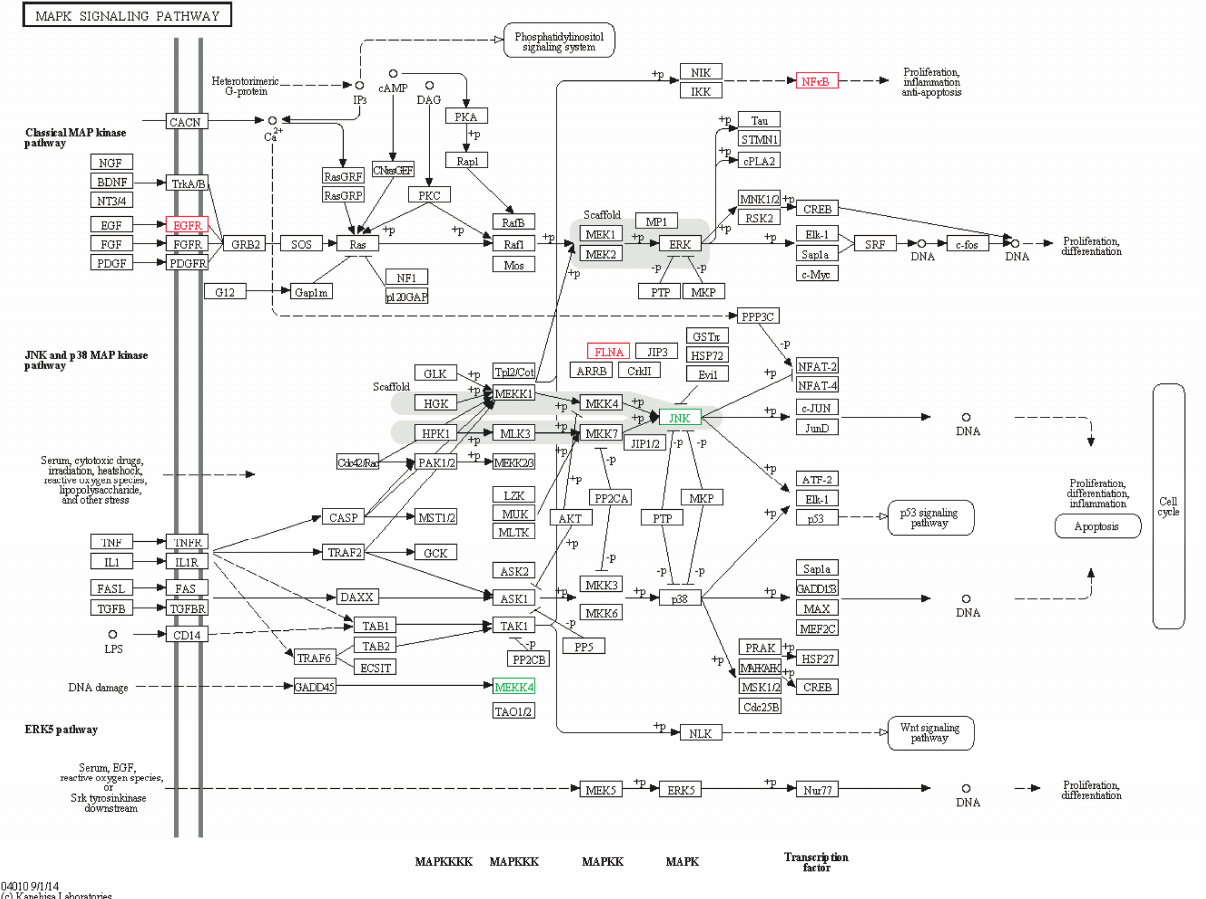
Figure 10. MAPK signaling pathway. Red boxes represent up-regulated genes, and green boxes represent down-regulated